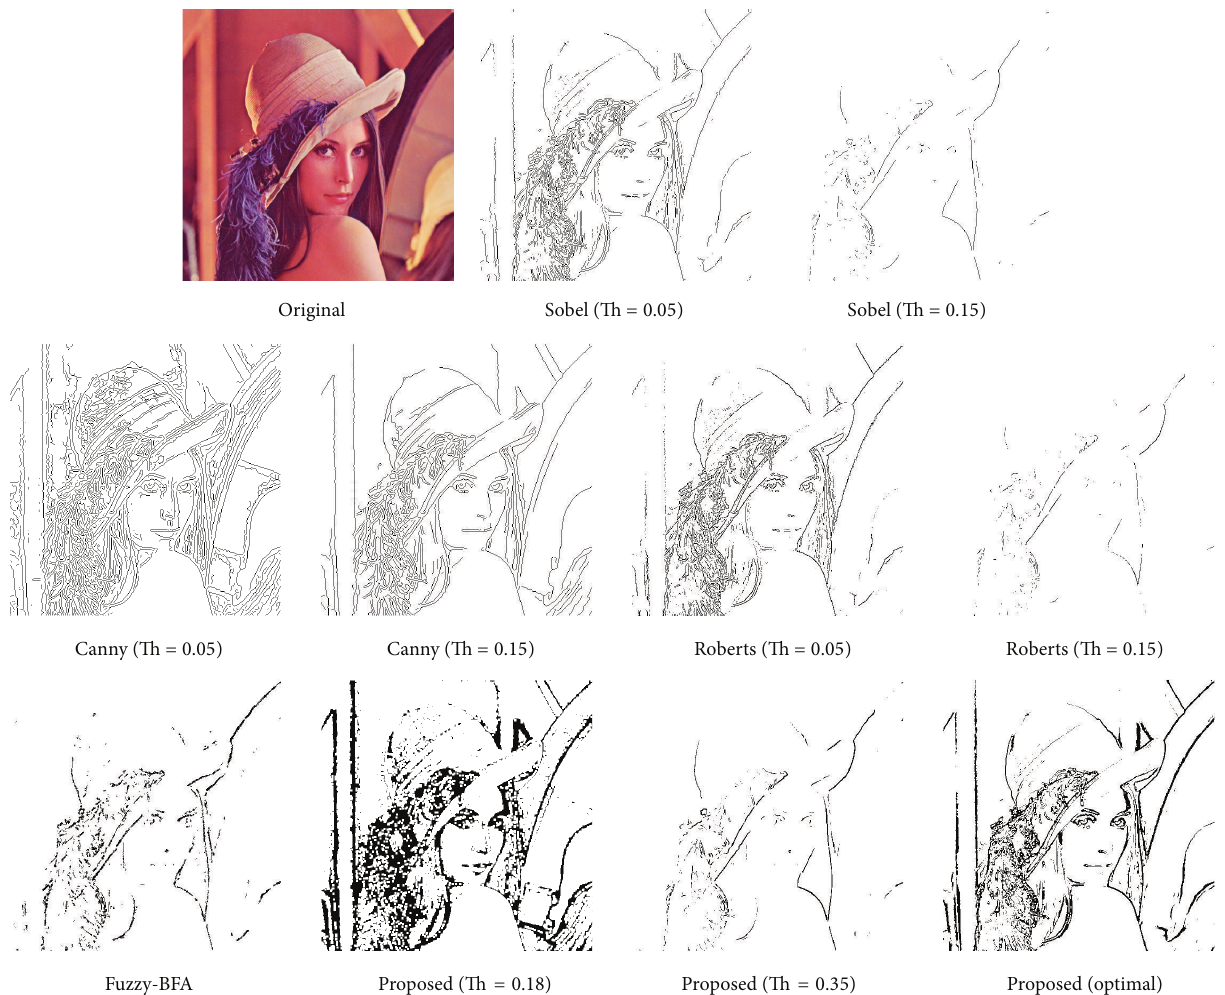
Figure 9: Edge detection results of “lena” image: Sobel, Canny’s, and Roberts methods using thresholds = 0.05 and 0.15; fuzzy-BFA method; proposed method with fixed thresholds (0.18 and 0.35) and optimal threshold.